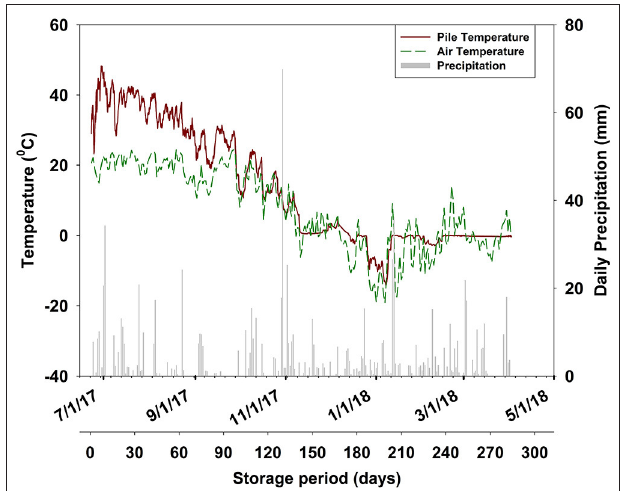
FIGURE 2 | Daily mean air temperature, precipitation, and pile temperature measured at 0.5–1 meter from the surface of a summer willow chips storage pile in Solvay, NY (the full dataset for air temperature is available at http:// prism.oregonstate.edu/explorer/).